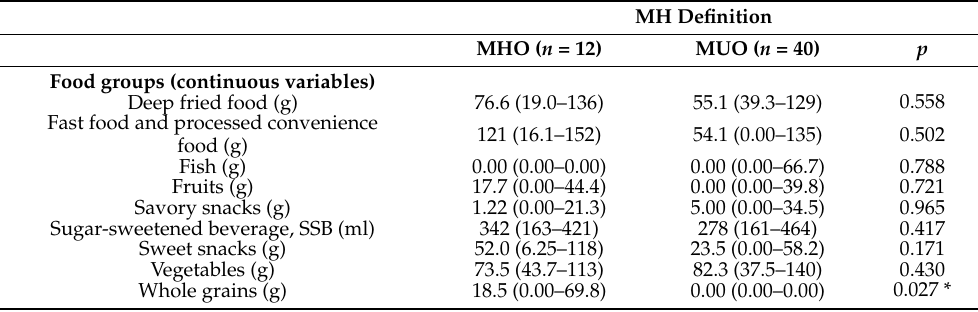
Table 2. Food groups, nutrients intakes and eating behavior between children/adolescents with MHO and children/adolescents with MUO by MH